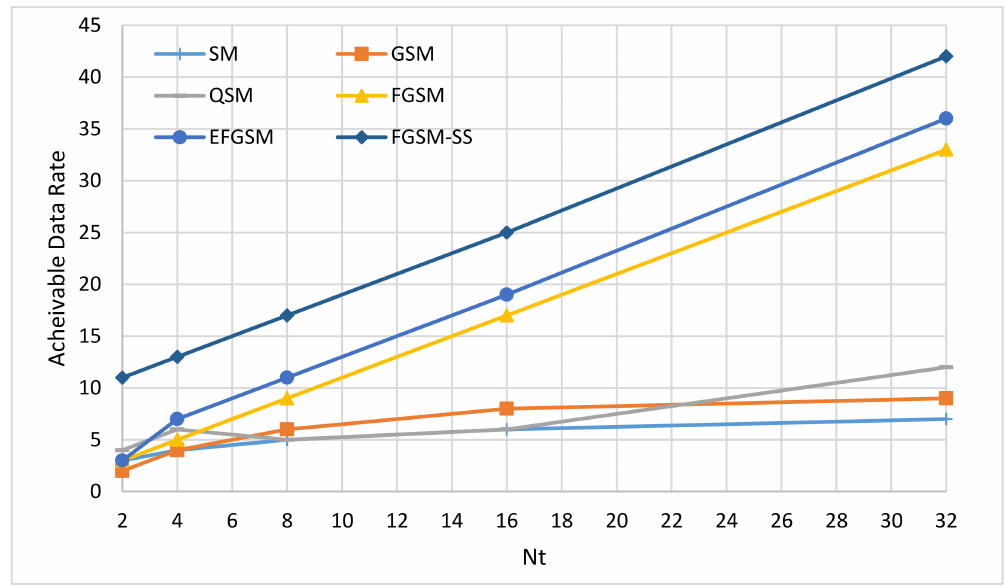
Figure 2. The maximum achievable data rates of di ff erent SMTs under di ff erent number of N t .